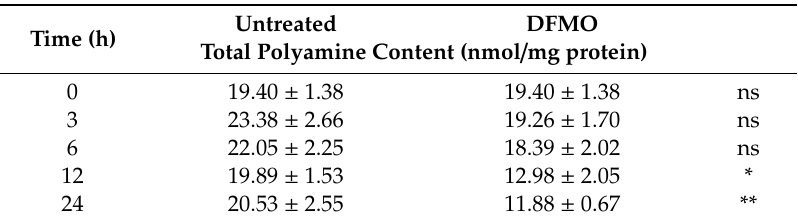
Table 1. The e ff ect of DFMO on total polyamine